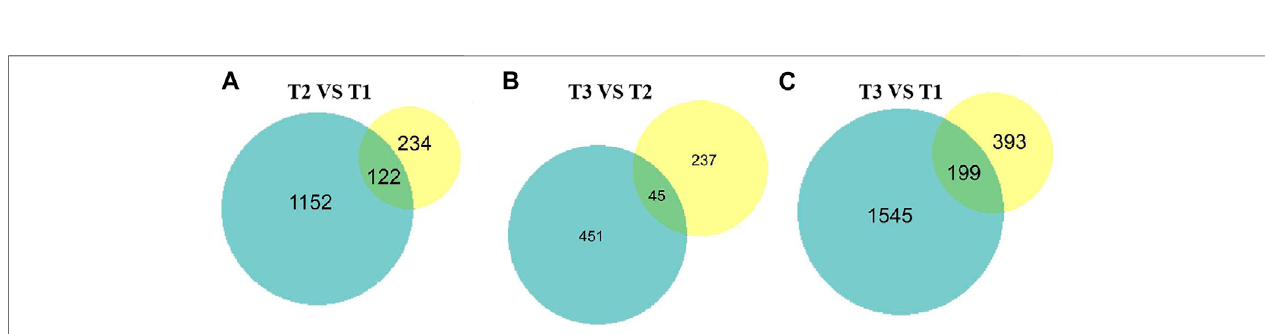
FIGURE 8 | Proteome and transcriptome expression Venn diagrams of three different sets of wool during curving period. Blue pie represent transcriptome, yellow pie represent proteome. (A) T2 VS. T1. (B) T3 VS. T2. (C) T3 VS. T1.